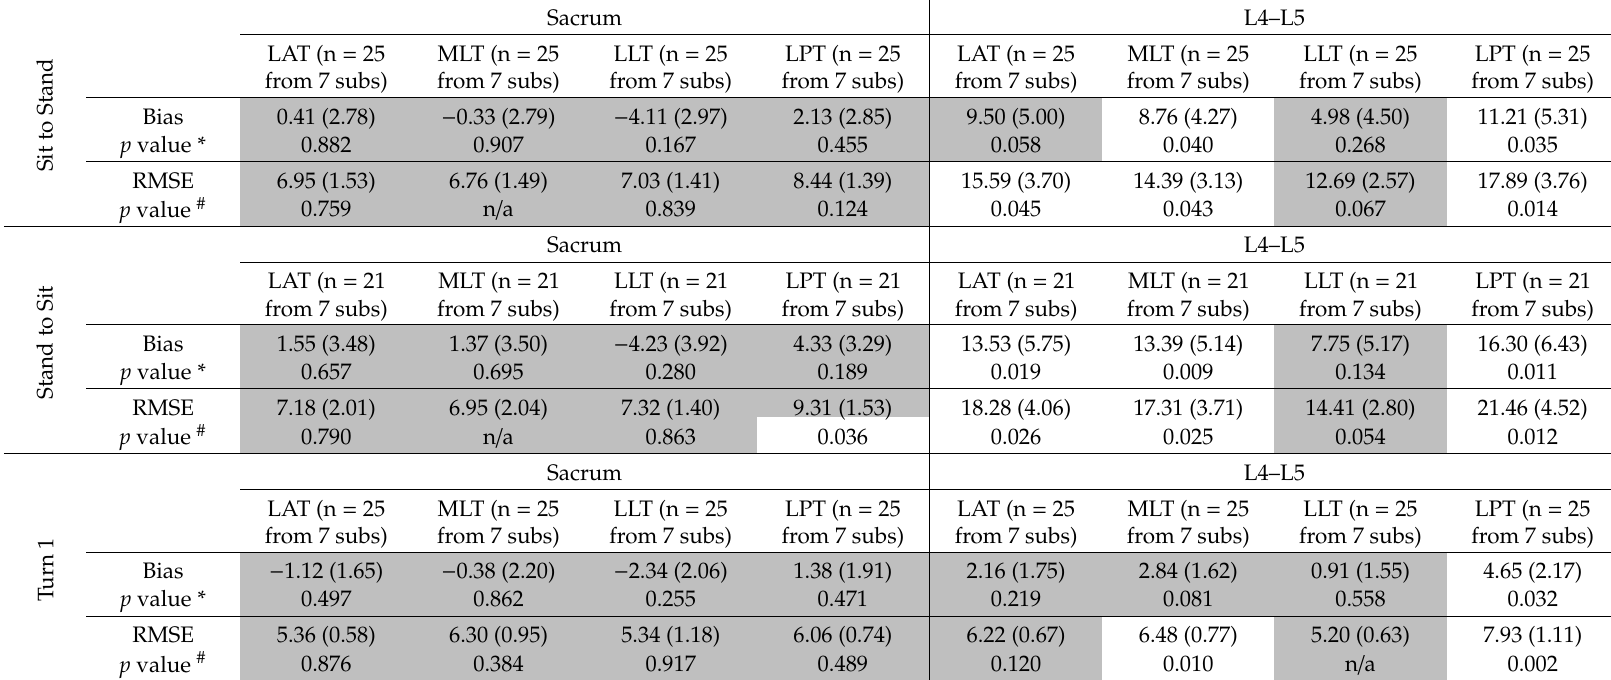
Table 6. Hip flexion bias and RMSE [least squares mean (standard error)] for each sensor combination versus gold standard MOCAP